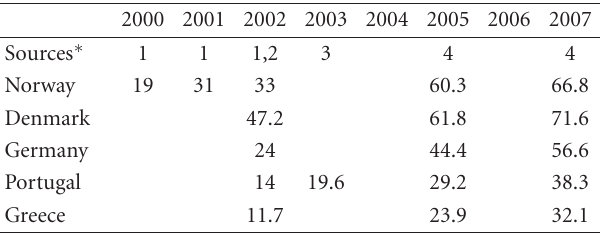
Figure 1: The development of the use of the Internet as a source of health information 2000–2007. Table 1: The use of the internet as a source of health information in five European countries, 2000–2007. Values are reported in